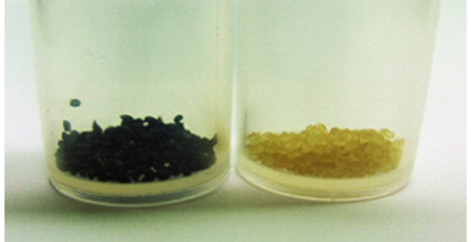
Figure A2. Images of Ca-Alg/GO and Ca-Alg dried beads (average diameter 0.46 ± 0.02 cm).